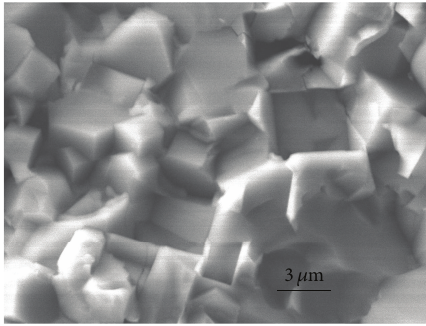
Figure 5: FESEM image of crack propagation paths in TiC-TiB 2 ceramic